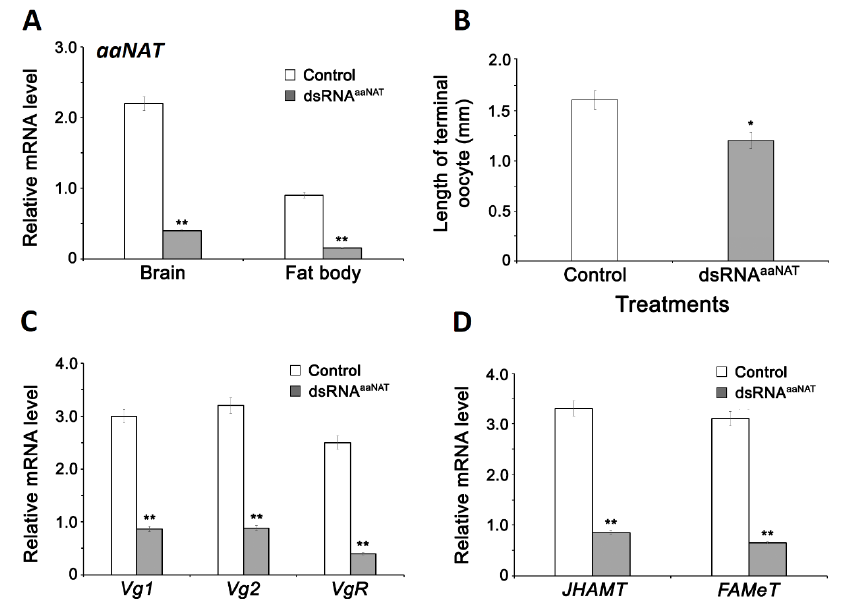
Figure 1. Aralkylamine N-acetyltransferase (aaNAT) acts in di ff erent aspects of vitellogenesis. ( A ) The relative expression of aaNAT mRNA in female brain and fat body compared to actin standard in adult females of P. americana 4 days post-injection with dsRNA aaNAT . ( B ) Oocyte length of adult females of P. americana 4 days post-injection with dsRNA aaNAT . ( C ) Expression of vitellogenin 1 and 2 ( Vg1 and Vg2 ) and vitellogenin receptor ( VgR ) mRNAs in female fat body of P. americana 4 days after dsRNA aaNAT injection. ( D ) Expression of genes encoding JH acid methyltransferase ( JHAMT ) and farnesoate O -methyltransferases ( FAMeT ) in the brain of adult females of P. americana 4 days post-injection with dsRNA aaNAT . Data are presented as mean ± SEM. The significant di ff erences are indicated by * ( p < 0.05; B ) or ** ( p < 0.01; A , C , D ), as compared to the controls, using Student’s t